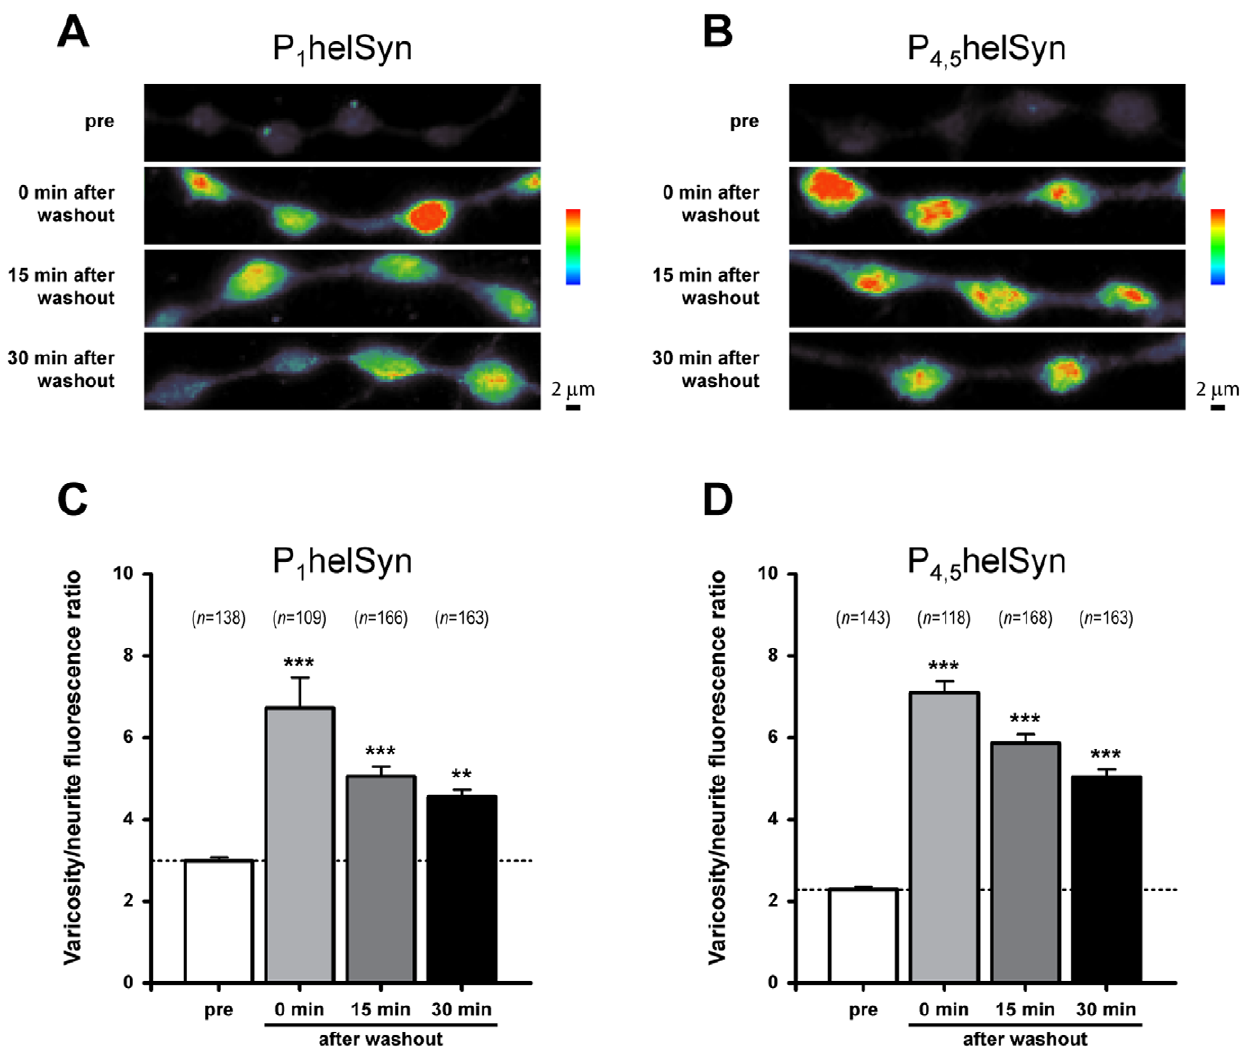
Figure 9. PTZ-induced epileptiform activity promotes a prolonged phosphorylation of synapsin domain A and B. (A,B) Pseudocolour representative acquisitions of B2 varicosities and neurites fixed before 40 mM PTZ treatment and every 15 minutes after drug washout. Cells were then immunolabelled with either a -P 1 helSyn or a -P 4,5 helSyn antibodies, as indicated. Scale bars: 2 m m. (C,D) Bar graphs showing the mean varicosity/ neurite fluorescence ratio for synapsin phospho-levels measured as previously reported. A statistically significant increase in synapsin phosphorylation at both phospho-sites was observed even 30 minutes after PTZ washout. The corresponding number of examined varicosities ( n ) is indicated on each